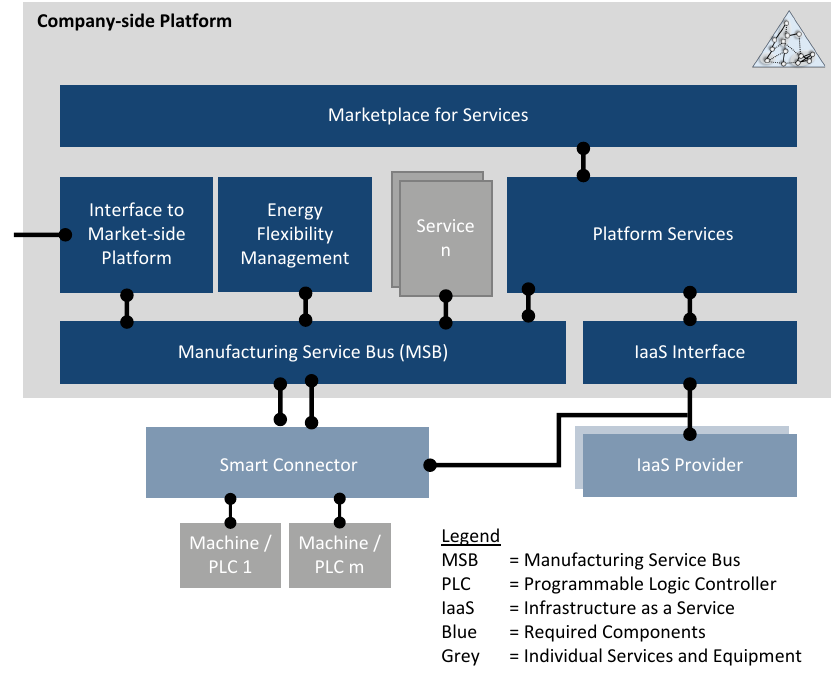
Figure 3. Architecture of the company-side